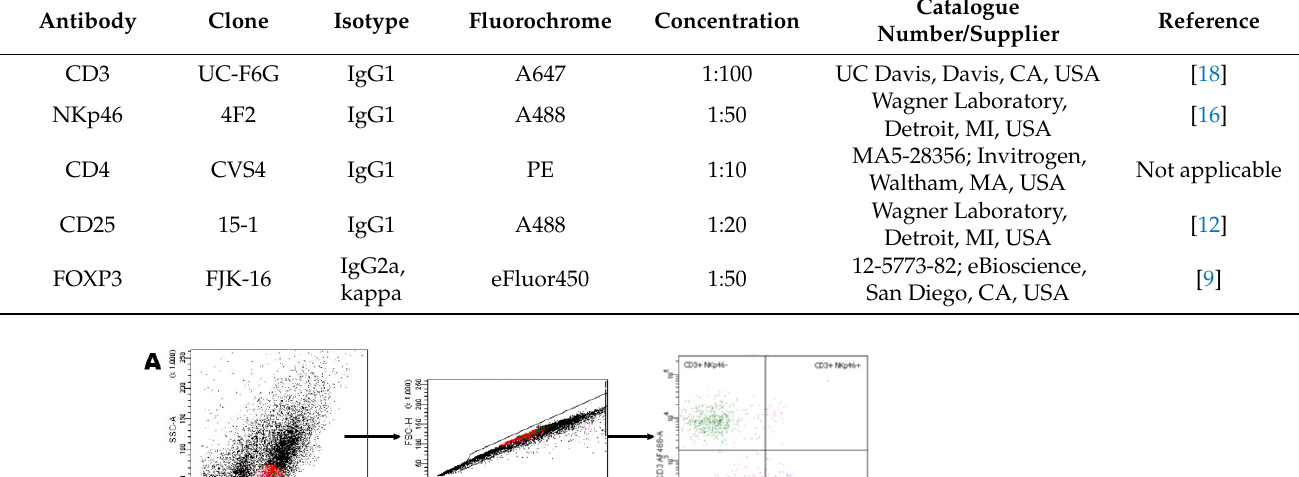
Table 1. Antibodies used in flow cytometry analysis to determine the presence of NK cells and regulatory T cells (Tregs) in mares’ endometrium.